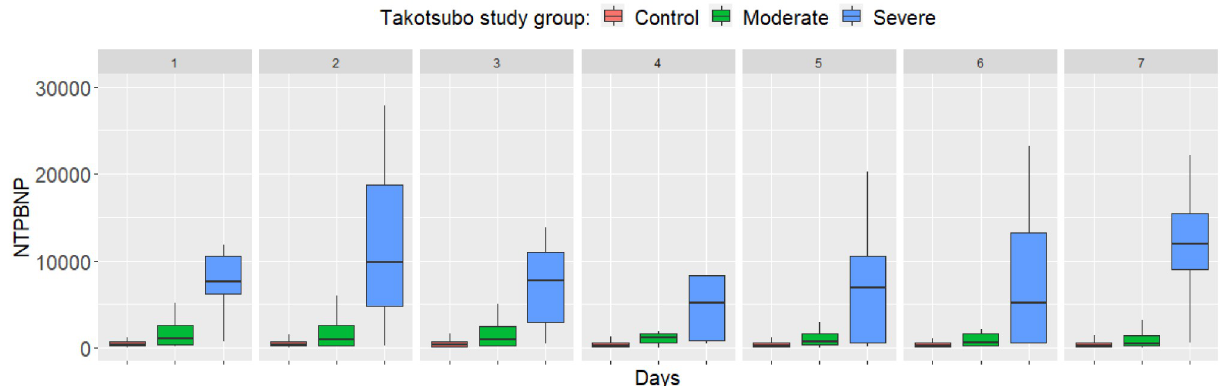
Fig 3. Differences in N-terminal pro-brain-type natriuretic peptide (NTPBNP) between study groups from day 1 to 7. Boxplots show the median, upper and lower quartiles, and minimum and maximum values, with outliers omitted for clarity. Differences are highly significant each day (p < 0.001).